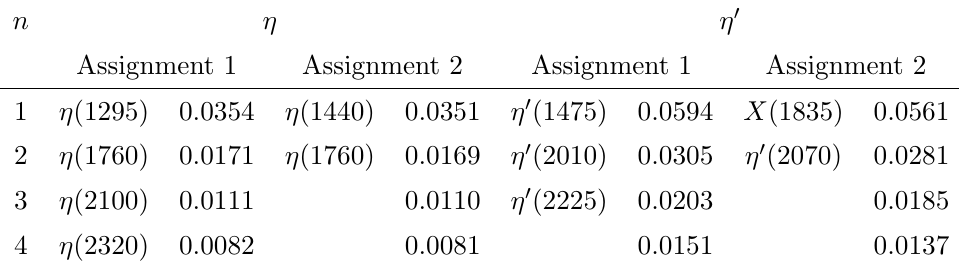
Table 3. Two-photon couplings, F P(cid:13)(cid:13) , of excited (cid:17) ( 0 ) states from the large- N c Regge model (4.34), in units of GeV (cid:0) 1 . \Assignment 1" and \Assignment 2" refer to the assignments of (cid:17) ( 0 ) excitations shown in (cid:12)gure 6 and suggested in refs. [90, 108] and [113, table 27], respectively. and the ground-state (cid:17) 0 contribution to ( g (cid:0) 2)